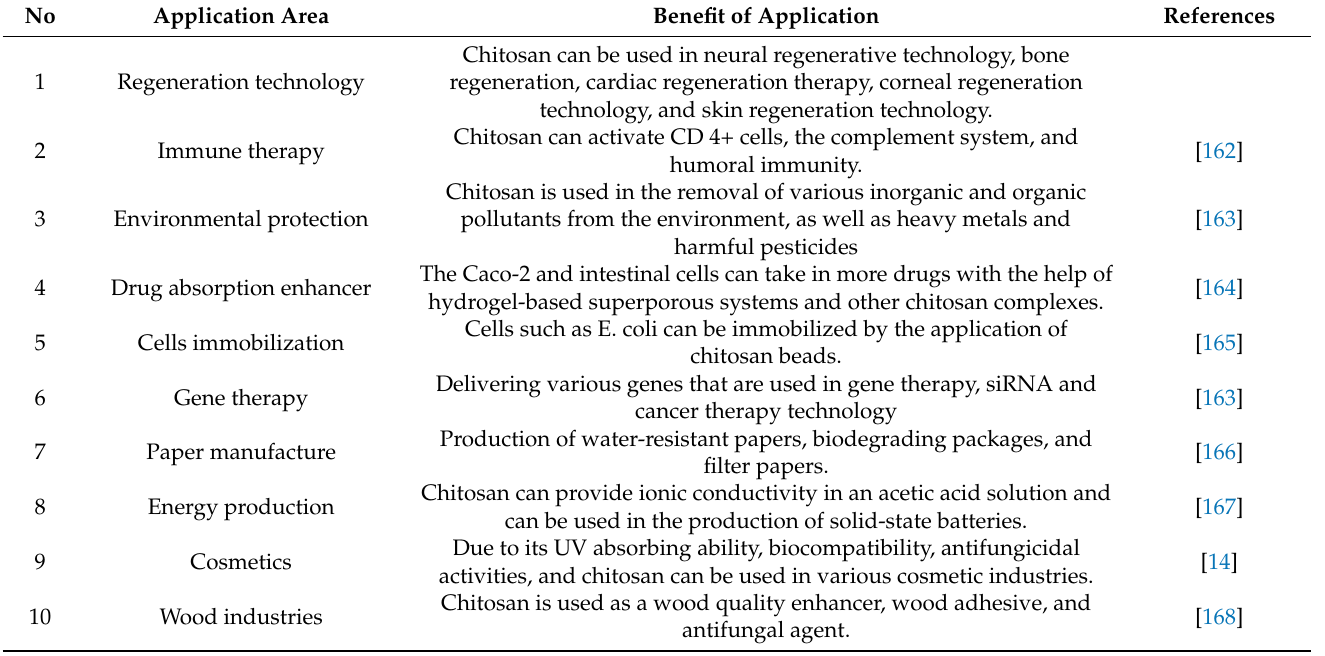
Table 2. Selected other applications of chitosan in different